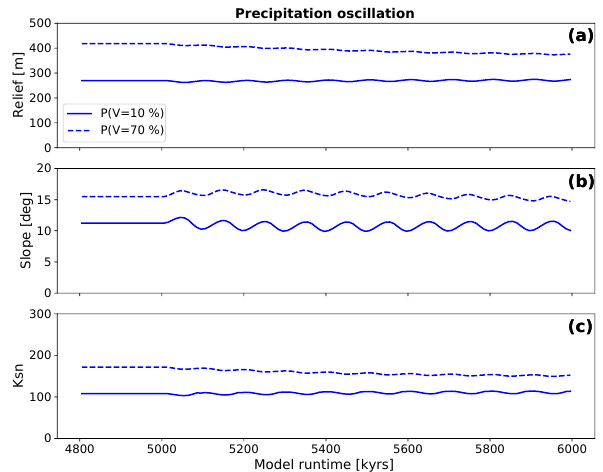
Figure 12. Evolution of topographic metrics for simulations with oscillating mean annual precipitation and constant vegetation cover. The vegetation cover was held constant at the value corresponding to the precipitation rate prior to the onset of the transient at 5000kyr. Panels (a) , (b) , and (c) show the mean basin relief, the mean basin slope, and the mean basin channel steepness ( K sn ), respectively.